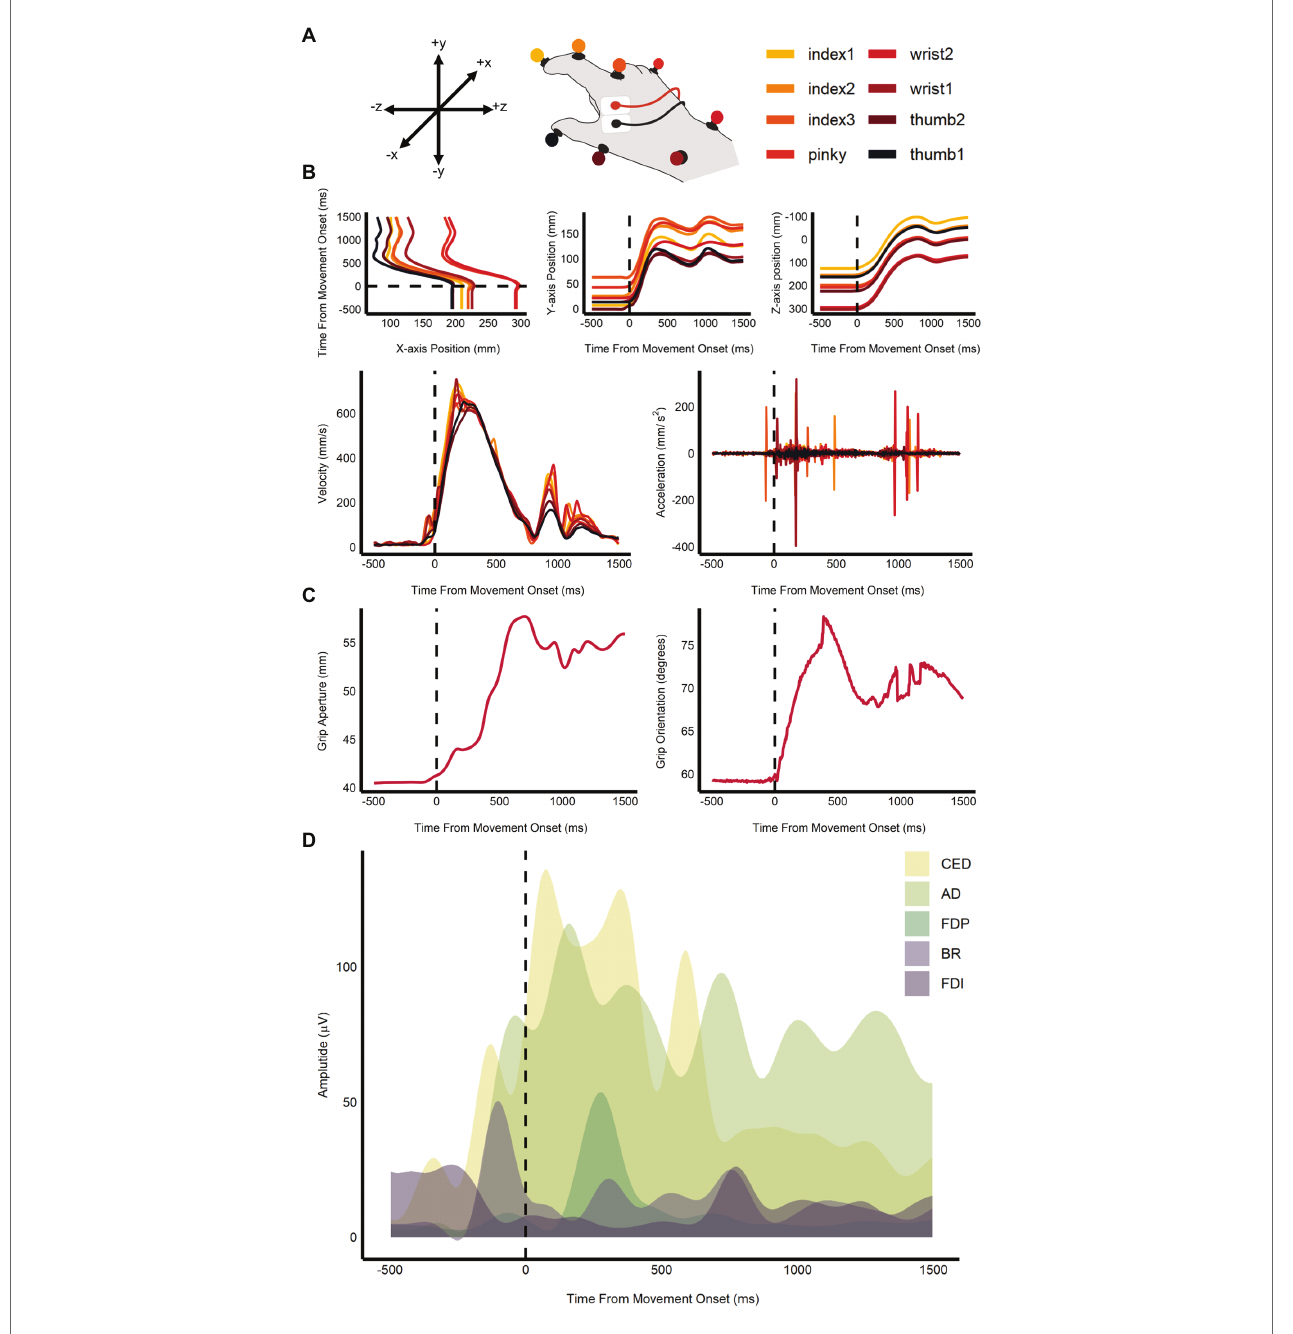
FIGURE 2 | Sample of kinematic and EMG measures used in the multivariate analysis. Plot shows (A) the coordinate map of the x , y , and z -axes and an illustration of the markers’ position on the hand; (B) change in marker position, velocity, and acceleration over time; (C) change in grip aperture and orientation over time; and (D) plot of EMG amplitudes in the five recorded muscles: anterior deltoid (AD), brachioradialis (BR), common extensor digitorum (CED), first dorsal interosseous (FDI), and the flexor digitorum profundus (FDP) for one trial. The dashed line represents movement